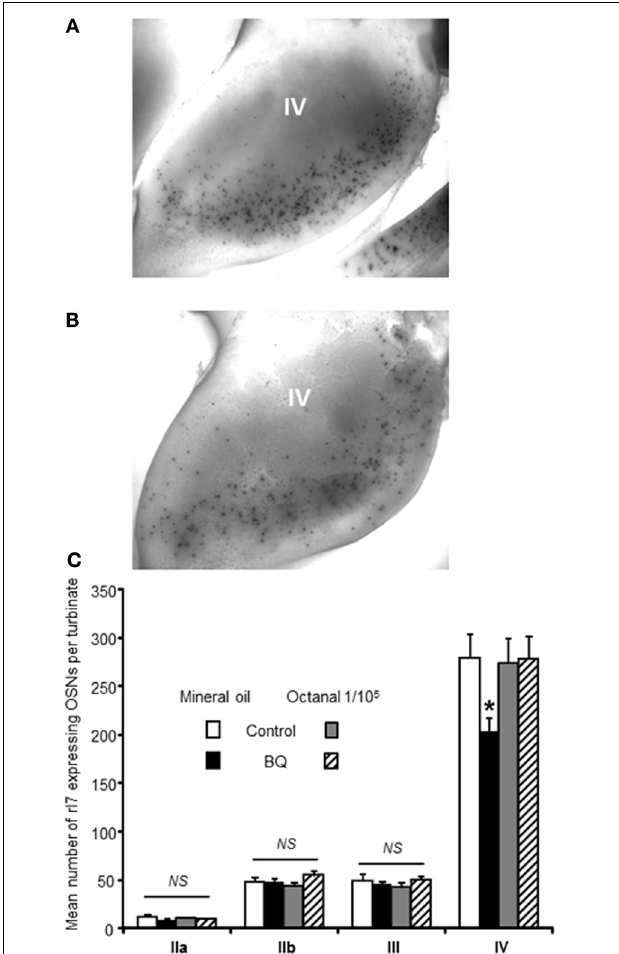
FIGURE 3 | Number of rI7-expressing OSNs is decreased by BQ except in presence of its cognate ligand octanal. Representative picture of turbinate IV after whole mount in situ hybridization against rI7 for (A) a control animal or (B) a BQ treated animal both odorized with mineral oil. (C) The number of rI7-expressing OSNs present at the surface of the turbinates was compared between pups treated with endothelin receptor antagonists (BQ) or control littermates. Dam was sprayed with either mineral oil or octanal diluted in mineral oil during pup’s treatment. Values are expressed as the mean number of rI7-expressing OSNs ± s.e.m. ( n = 6; ∗ P < 0 .